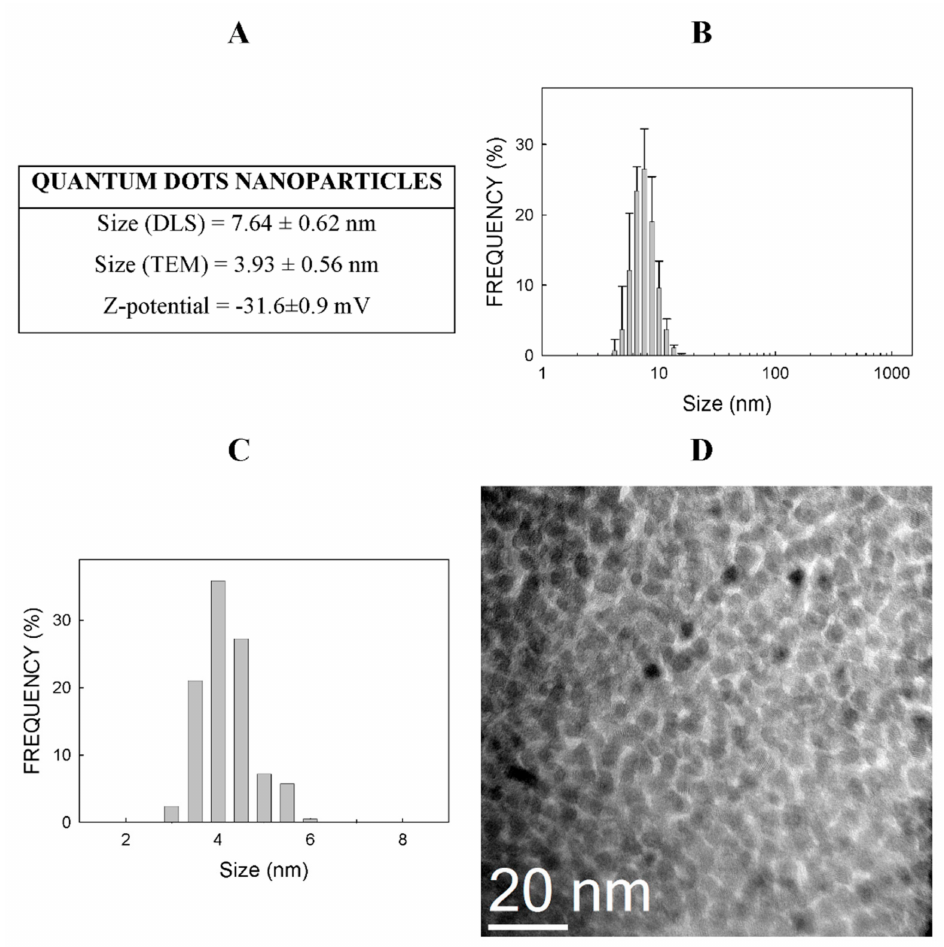
Figure 1. Physico-chemical properties of CdSe-QDs. Physical properties (panel ( A )) and distribution of sizes as determined by DLS (panel ( B )) and TEM (panel ( C )). Panel ( D ) shows a picture of CdSe-QDs under TEM. Determinations were performed by Nanoimmunotech SL (https://nanoimmunotech. eu/en, accessed on 1 February 2022). DLS was analyzed in quintuplicate with a minimum of 10